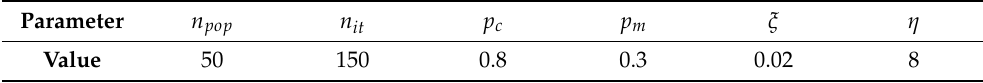
Table 4. Parameters for GA simulations in different